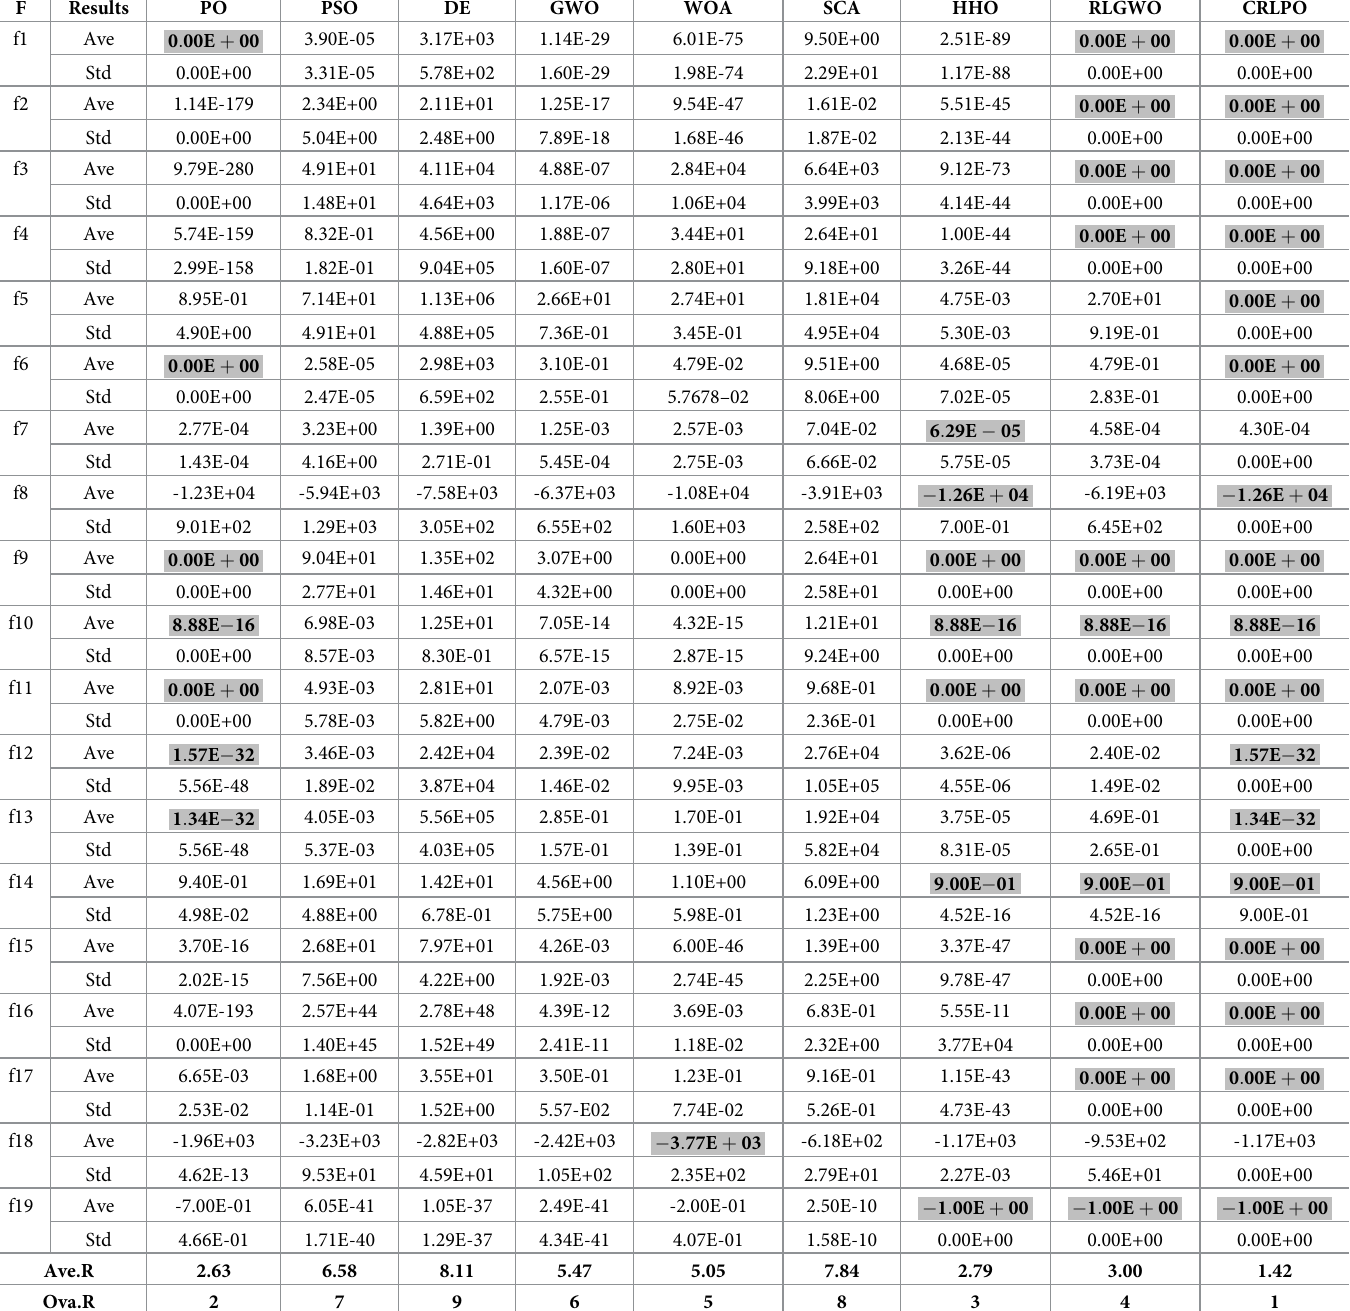
Table 2. Experimental results of 19 benchmark functions from Table 1 with 30